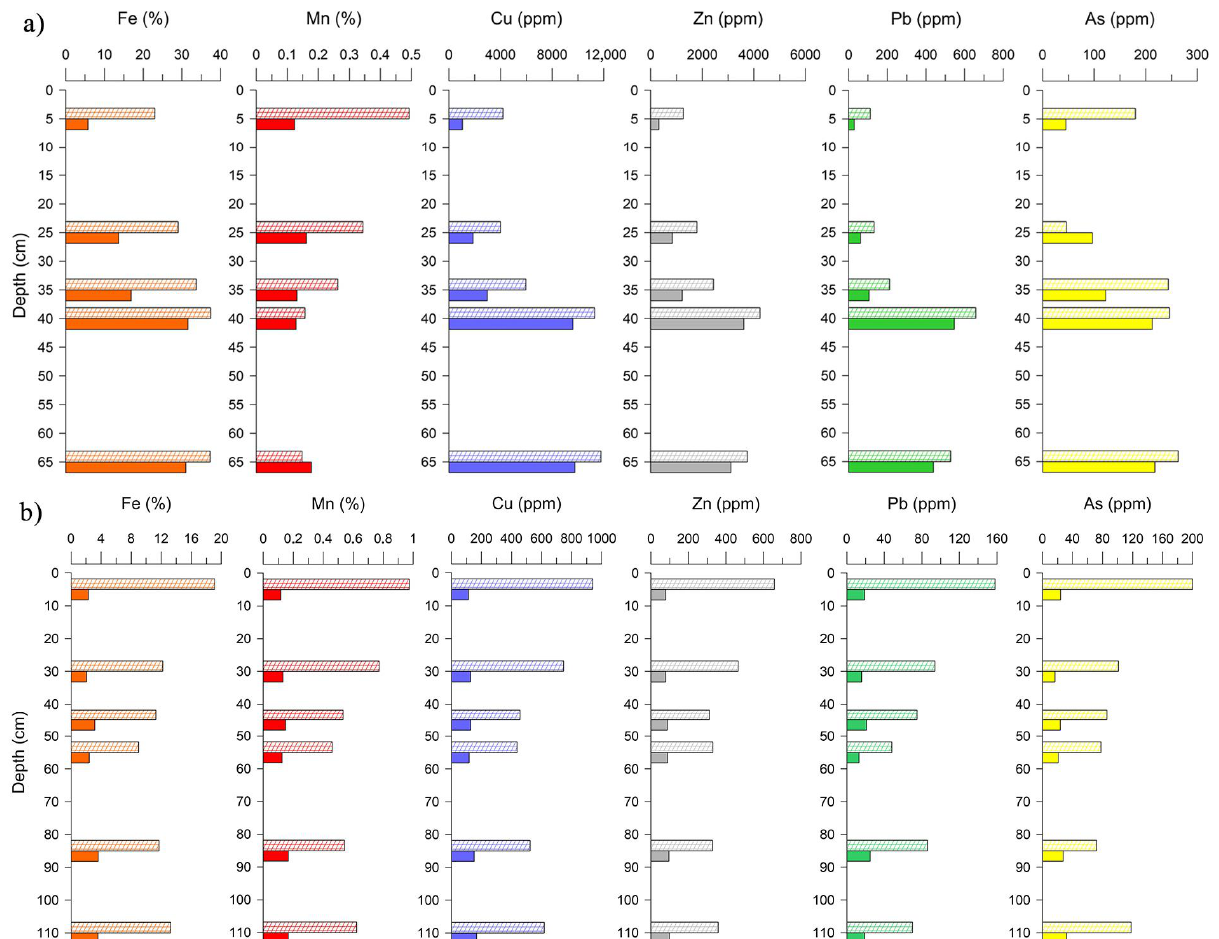
Figure 4. Down-core metal distribution in 184k ( a ) and the background 215k ( b ) sediment cores. Metal contents in bulk sediment are shown with dense fill, while those on the carbonate free basis (cfb)—fill with hatching.